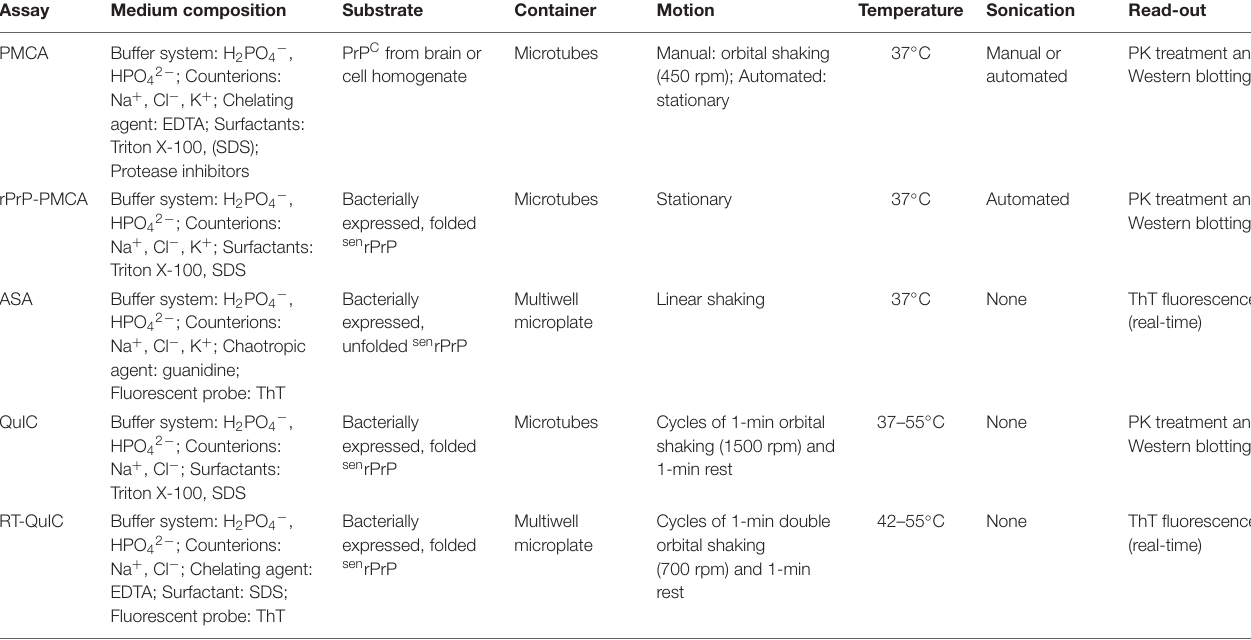
TABLE 2 | In vitro cell-free PrP conversion assays. Assay Medium composition Substrate Container Motion Temperature Sonication Read-out